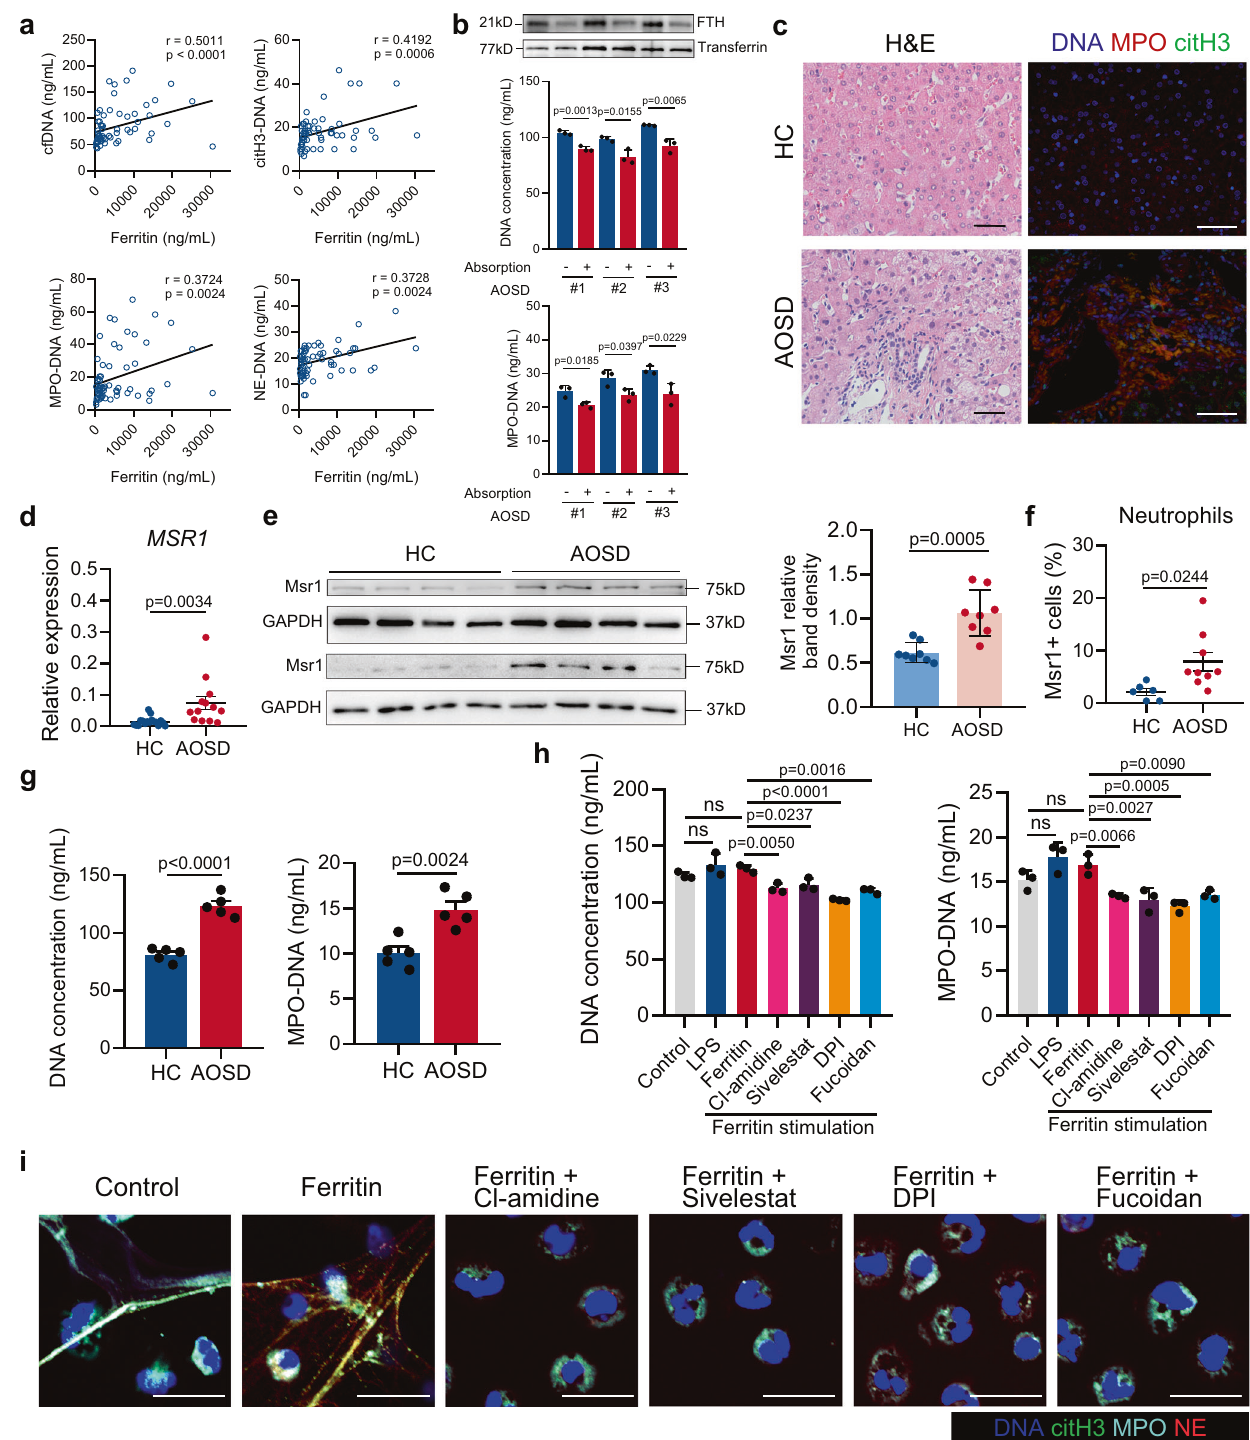
containing protease inhibitor cocktails (Roche Diagnostics, Man- nheim, Germany) and phosSTOP (Roche Diagnostics, Mannheim, Germany). The protein lysates (20 – 40 μ g protein) were separated on 10% SDS/PAGE gel and transferred onto polyvinylidene fl uoride membrane. Membranes were incubated with primary antibodies against rabbit anti-ERK (1:1000, 137F5 clone, 4695, CST), rabbit anti-